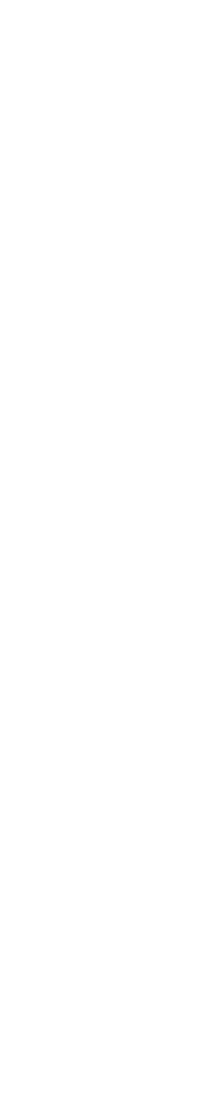
FIGURE 1 | Topic administration with TET NE upregulates tmTNF expression by DCs and expansion of TNFR2 + Tregs in IMQ-treated mice. The C57BL/6 mice (N = 9) were treated with imiquimod (IMQ) for 6 days. TET NE treatment starts from the second day after IMQ treatment for 5 days. 24 hours later, the mice were sacri fi ced. tmTNF expression on CD11c + cells (A) , Proportion of Tregs in CD4 + cells (gating on TCR b + CD4 + cells, B ), expression of TNFR2 by Tregs (gated on Foxp3 + Tregs, C ) and expression of Ki-67 by Tregs (gated on Foxp3 + Tregs, D ) in the spleen were analyzed by FACS. Dot histogram: isotype control. (E – H) show summarized data with statistical signi fi cance. Data were shown as means ± SEM. -: IMQ without treatment; Blank: IMQ + blank gel treatment. * P < 0.05, ** P < 0.01, *** P < 0.001, compared with IMQ group (denoted as